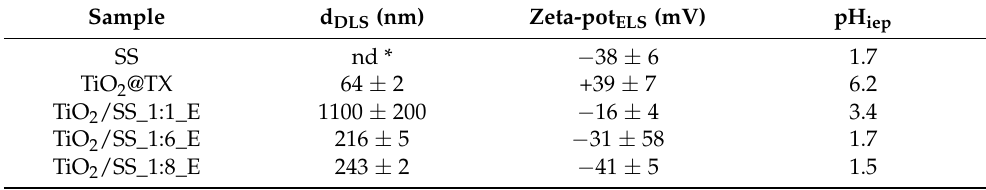
Table 2. Data from colloidal characterization of TiO 2 /SS_E samples obtained via heterocoagulation.